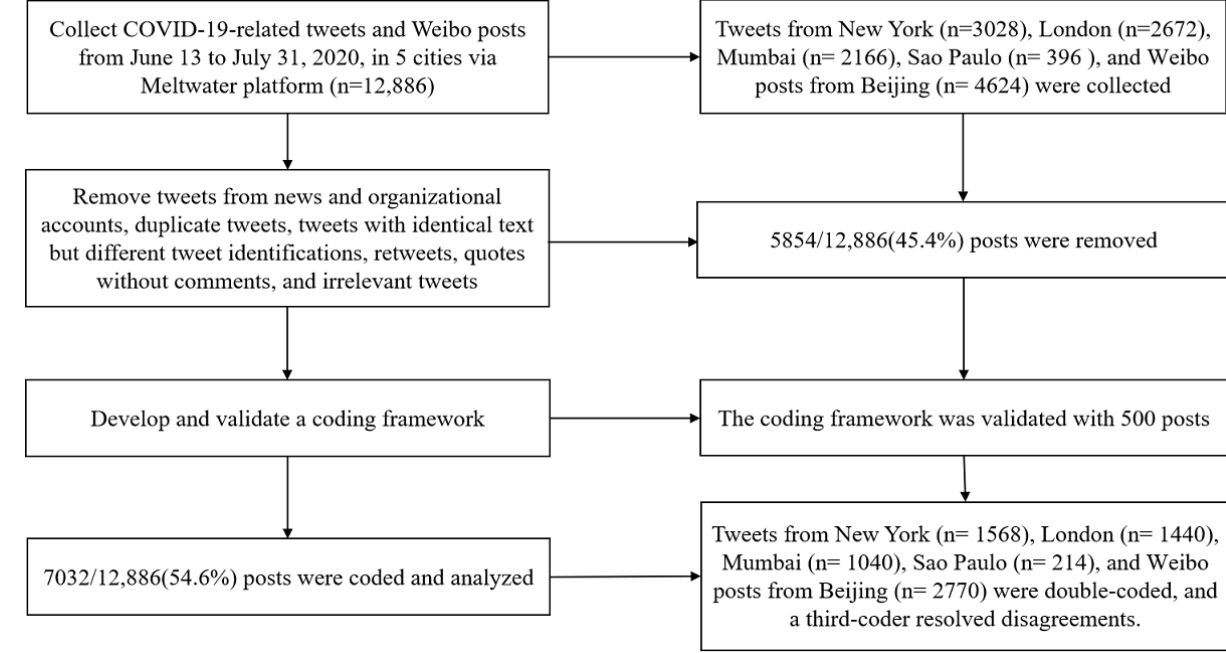
Figure 1. Flowchart of data process and